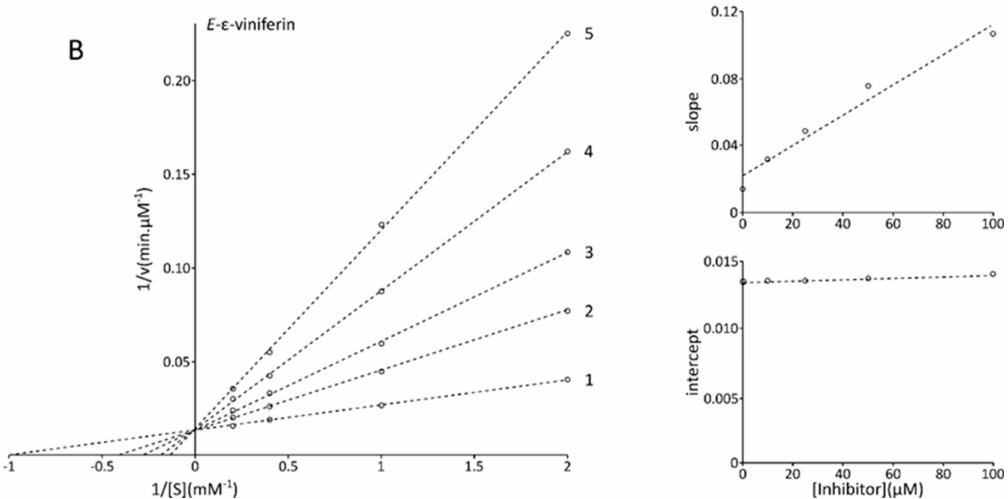
Figure 4. Lineweaver–Burk plots for inhibition of mushroom tyrosinase by E -resveratrol ( A ) and E - ε -viniferin ( B ). Concentrations of E -resveratrol ( A ) and E - ε -viniferin for curves 1–5 were 0, 10, 25, 50 and 100 µ M, respectively. The inset represents the secondary plots representing slopes of the double reciprocal plot versus the concentrations of each inhibitor (i.e., E -resveratrol ( A ) and E - ε -viniferin ( B )) used for the determination of K I and secondary plot of intercepts of the double reciprocal plot versus the concentrations of each inhibitor (i.e., E -resveratrol ( A ) and E - ε -viniferin ( B )) used for the determination of K